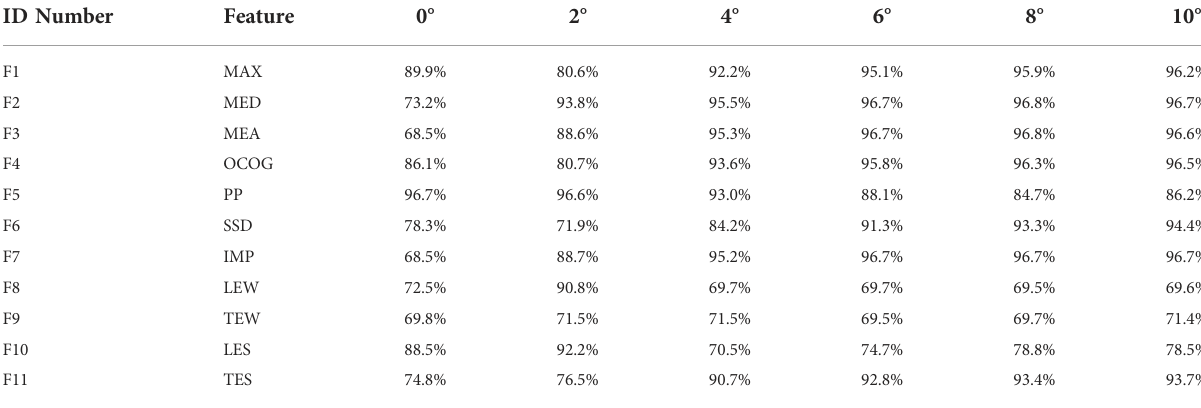
TABLE 3 Overall accuracies of single features at small incidence angles using the optimal classi fi er (the KNN method with Euclidean distance and k equal to 11).